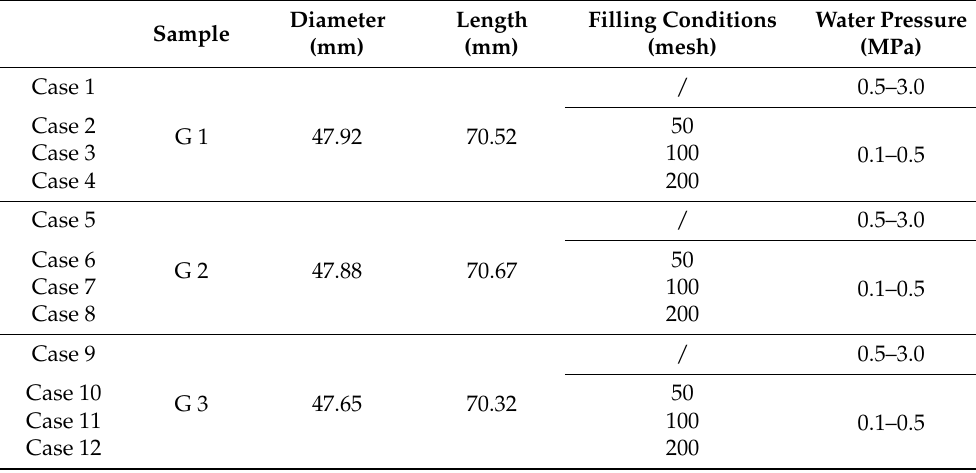
Figure 4. Sample and permeable stones. Table 1. The flow test cases.